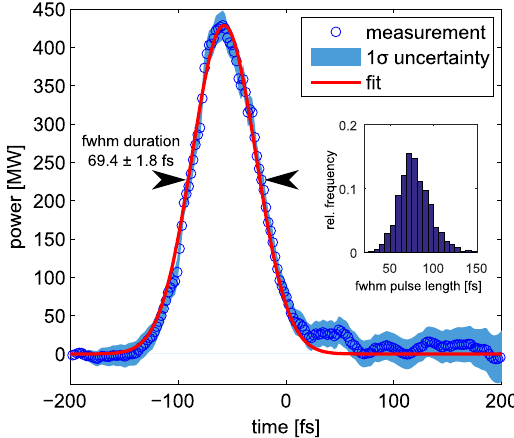
Figure 3. Reconstructed power profile from a typical seeded FEL pulse shown in Fig. 2b using the energy drop method. The blue dots show the reconstruction and the red curve shows a Gaussian fit with a peak power of P 0 = 429 MW. The shaded blue area shows the rms variation of the data derived from statistical errors of the reference bunches. The histogram inset shows the pulse length evaluation of 1979 shots of the present experimental campaign leading to τ FEL = (78.0 ± 18.4)